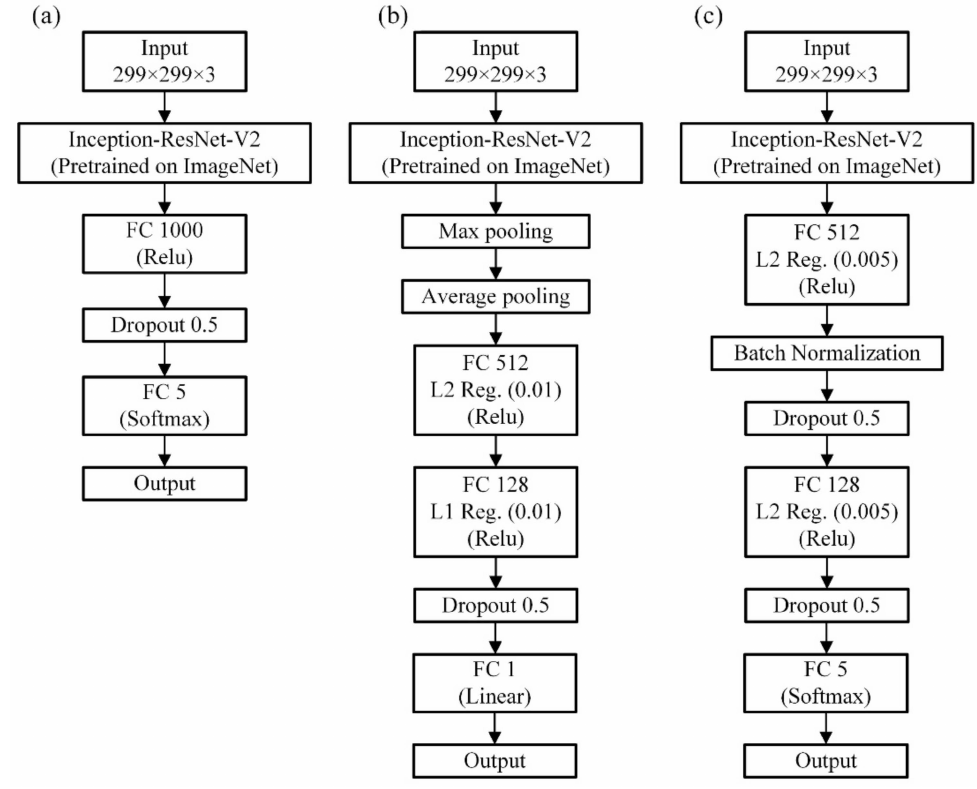
Figure 12. The classification model ( a ), the regression model ( b ), and the classification model ( c ) are utilized for the first, second, and third tasks,